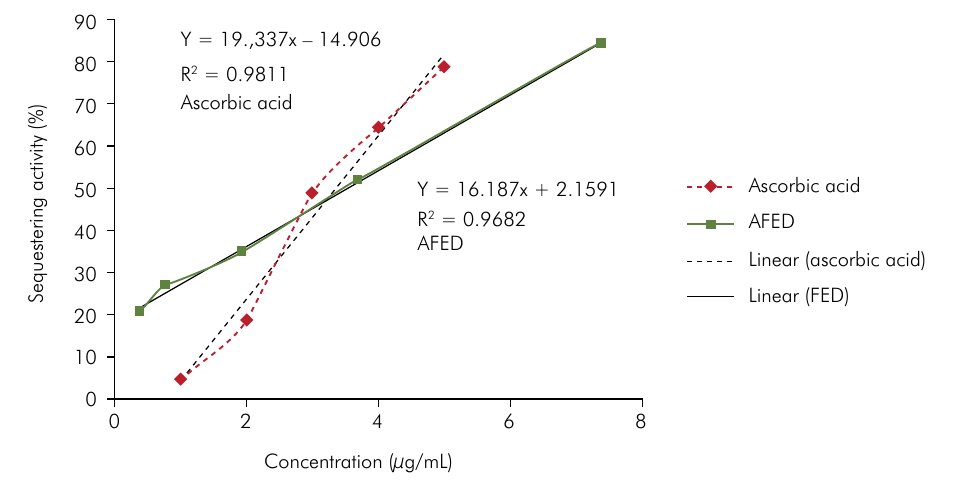
Figure 4. Antioxidant activity by reduction of the DPPH• radical from the acetone fraction of Eugenia dysenterica (AFED) and ascorbic acid standard. Inhibitory concentration 50% (IC 50) calculated by linear regression in relation to the estimated value of 100% for the ascorbic acid